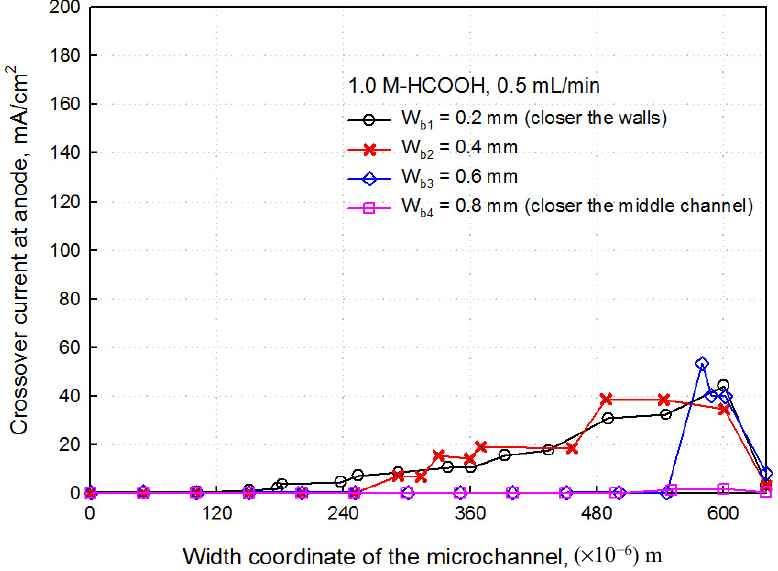
Figure 6. The effect of bubble growth on the crossover current at the anode along the microchannel at four specific positions of width coordinate of the channel using a volumetric flow rate of 0.5 mL/min with inlet [HCOOH] = 1.0 M.